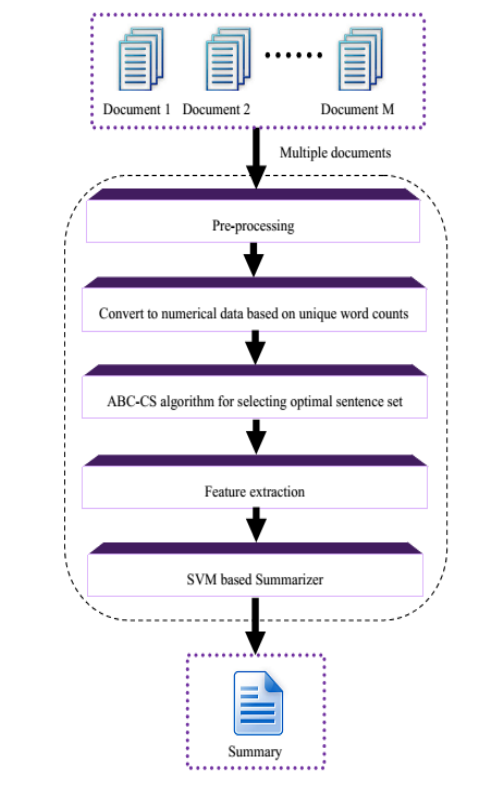
Figure 1. Overall Block diagram of proposed document summarization